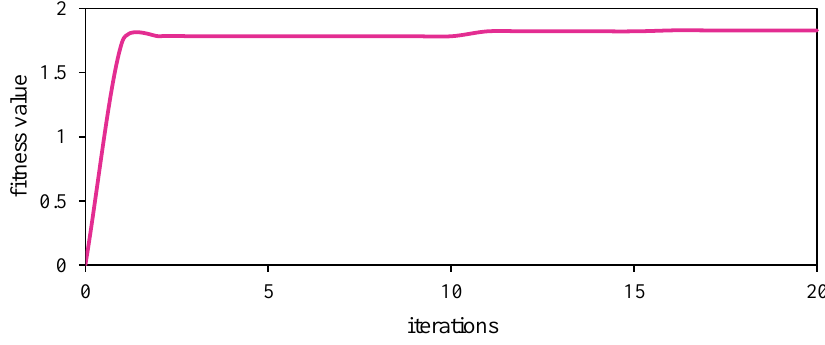
Figure 15. Fitness function of optimization processes with PSO